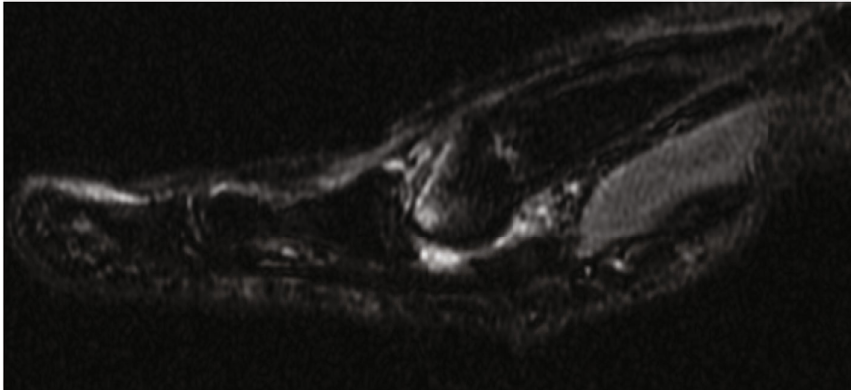
Figure 3: Preoperative right foot MRI performed 14-month status postdorsal cheilectomy demonstrating 50% loss of the fi rst metatarsal head.